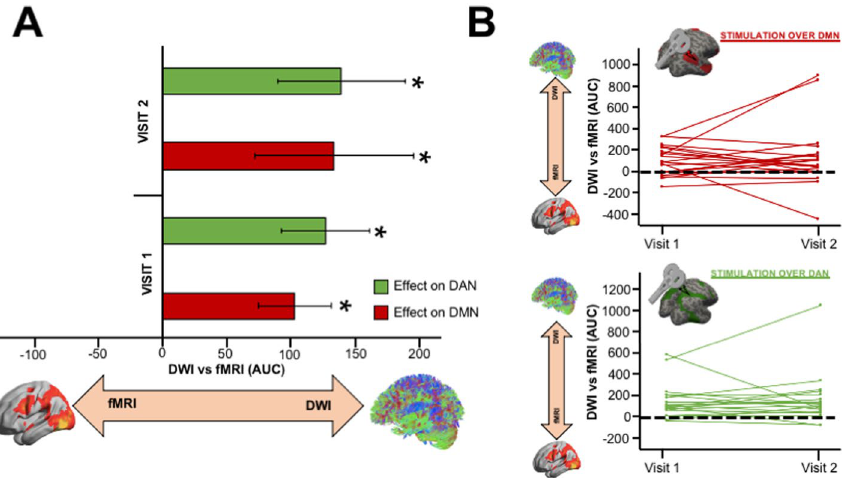
Figure 2. Propagation of the TMS-induced signal within DWI and fMRI projection maps. ( A ) Grand mean average and standard error of the mean (SEM) of the AUC extracted from DWI and fMRI projection maps. Significant positive values were found for both stimulation condition across visits indicating that the TMS- induced signal propagated more on DWI (rather than fMRI) projection map (Visit 1: DMN: average = 103.56, SEM = 28.26; Visit 2: DMN: average = 134.28, SEM = 62.02; Visit 1: DAN: average = 127.16, SEM = 34.48; Visit 2: DAN: average = 139.83, SEM = 49.86). ( B ) Test–retest reliability of the AUC extracted comparing the signal within DWI and fMRI projection maps. A high reproducibility across visits were found for both DMN (top, red lines) and DAN (bottom, green